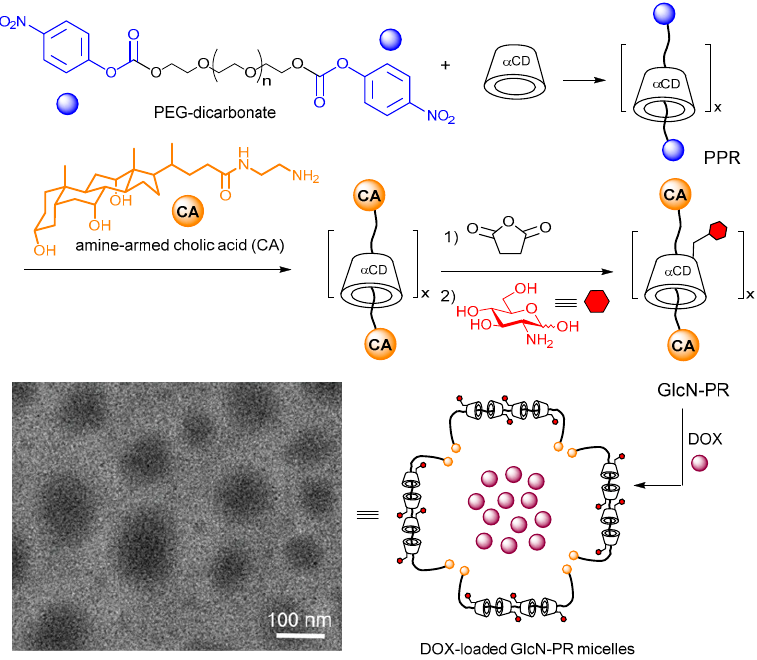
Figure 10. Polyrotaxane-based glycopolymers developed by Jia, Ren and coworkers [76] and a schematic representation of their self-assembly into doxorubicin-loaded micelles for the targeted delivery of the drug to tumor cells. A representative transmission electron microscopy (TEM) micrograph of the later is also shown. Adapted with permission from Reference